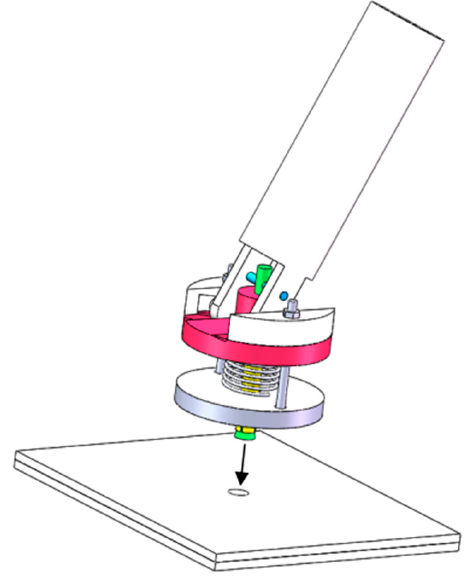
Figure 2. Preliminary installation